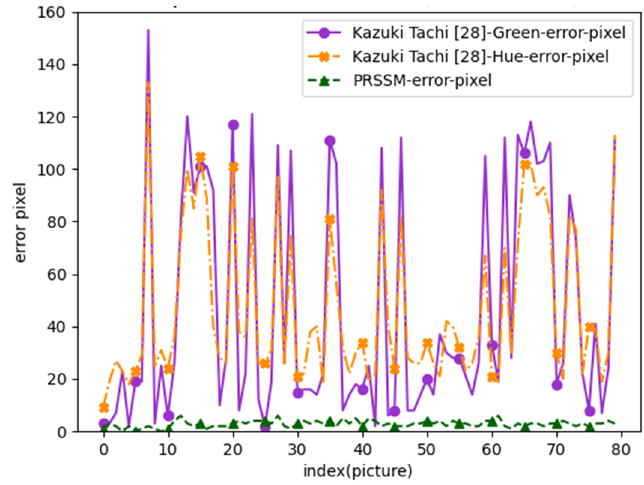
Figure 55. Measurement errors for Data Set